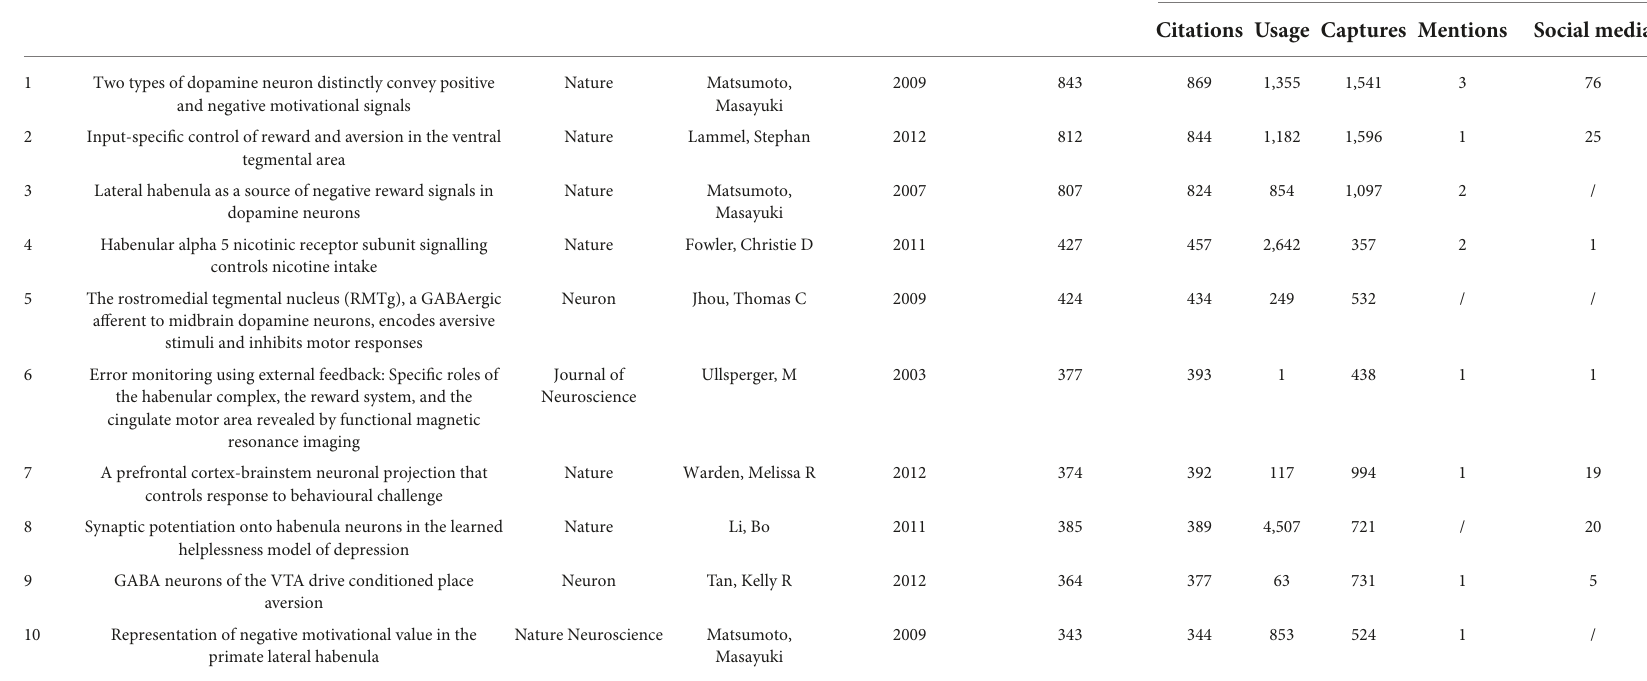
TABLE 1 The top 10 high-cited papers in habenula research during